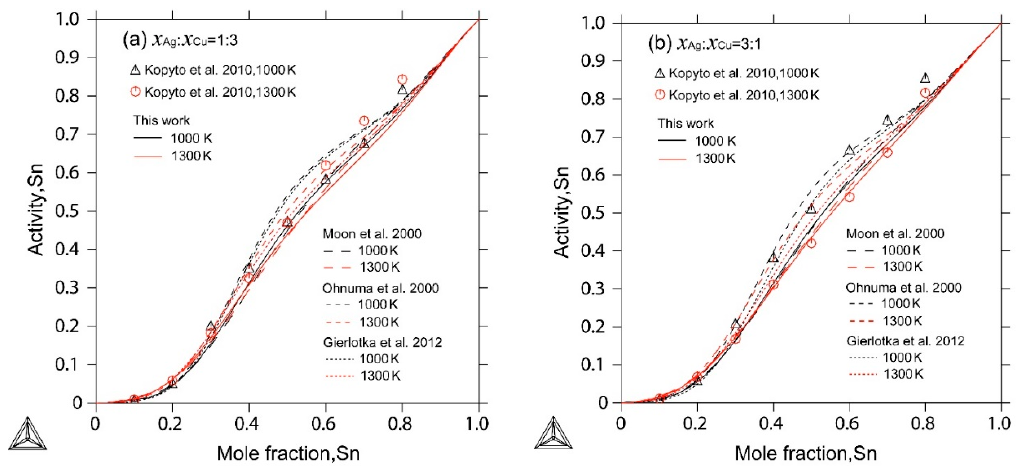
Commented [M11]: Same as the one above Commented [Q.S12R11]: Thanks for the comment.